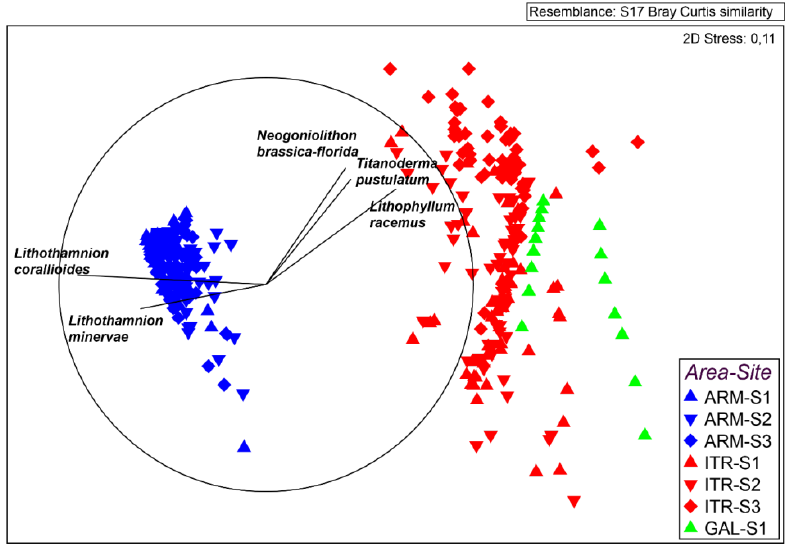
Figure 6. MDS plots on the basis of all the rhodoliths species found in the different study areas (ARM: Armeleia shoal; ITR: Tremiti Islands; GAL: Gallipoli).